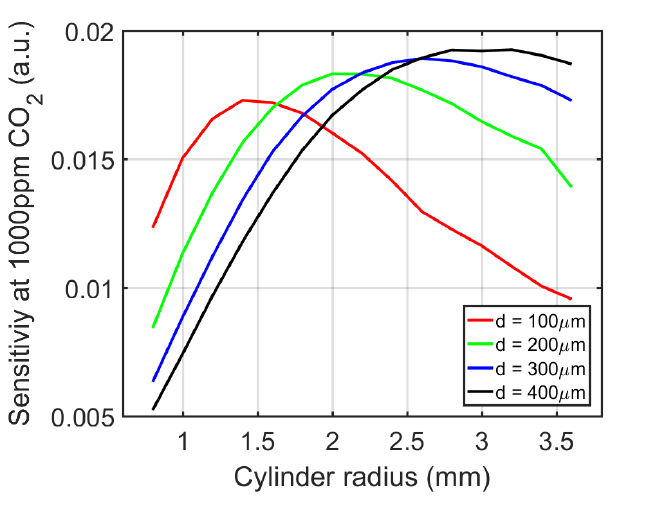
Figure 4. Sensor sensitivity S at CO 2 = 1000 ppm, for various cylinder radius and access waveguide width